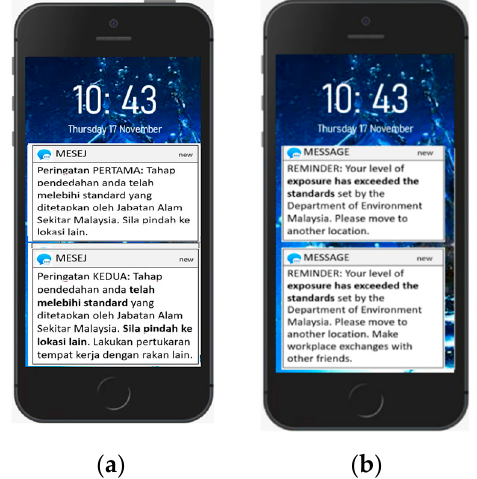
Figure 14. The smartphone display messages ( a ) in Malay language, and ( b ) in English Language.